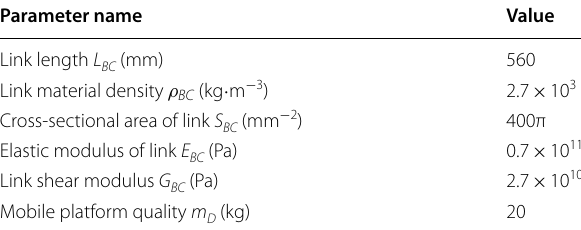
Table 3 Structure parameters of 5-PSS/UPU parallel